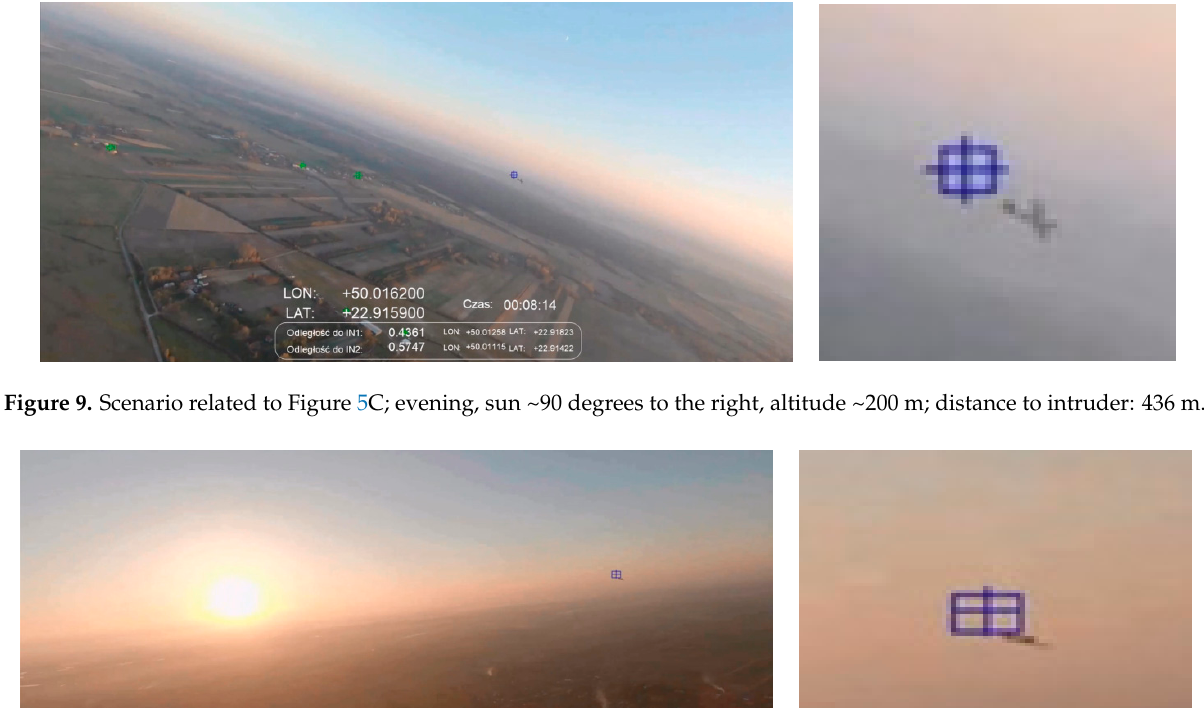
Figure 9. Scenario related to Figure 5C; evening, sun ~90 degrees to the right, altitude ~200 m; distance to intruder: 436 m. Sensors 2021 , 21 , x FOR PEER REVIEW Figure 8. Scenario related to Figure 5A; afternoon, sun ~120 degrees to the left, altitude ~300 m; distance to intruder: 188 m.